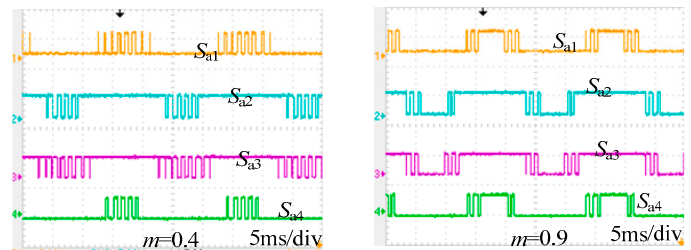
Figure 11. The experimental results of steady-state operation.